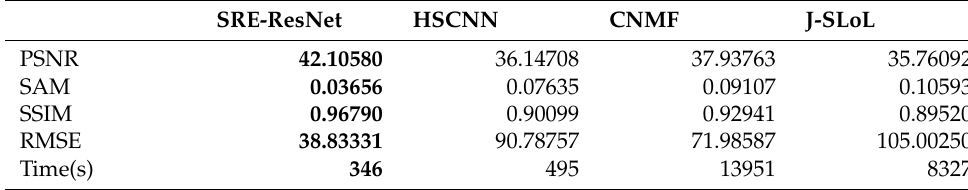
Table 5. Quantitative fusion evaluation of Dataset